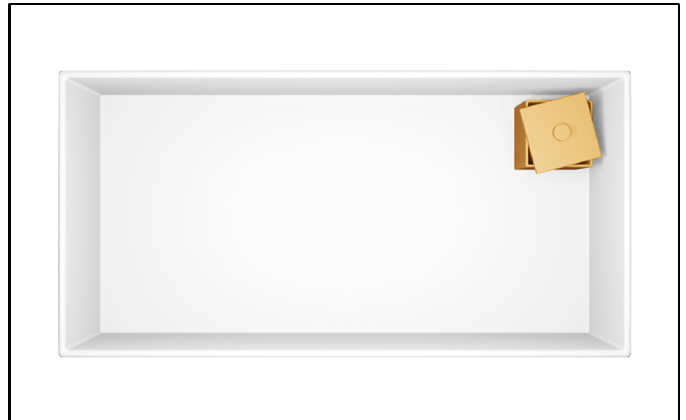
Figure 1. Within a rectangular white room, the corner with the box has a long surface on the left and a short one on the right (metric and sense attributes). The same is true for the location that is 180° rotationally symmetric corner. These two corners are geometrically identical, and the other two corners are characterized by opposite geometry (a long surface on the right and a short one on the left).